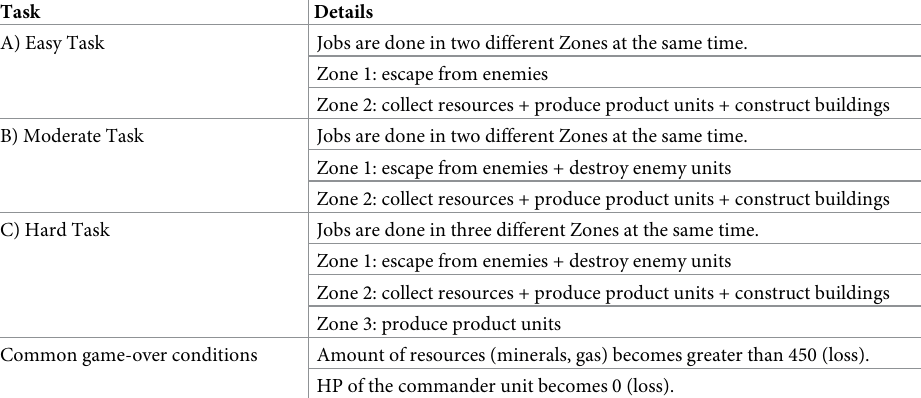
Table 2. Three types of task and common game-over